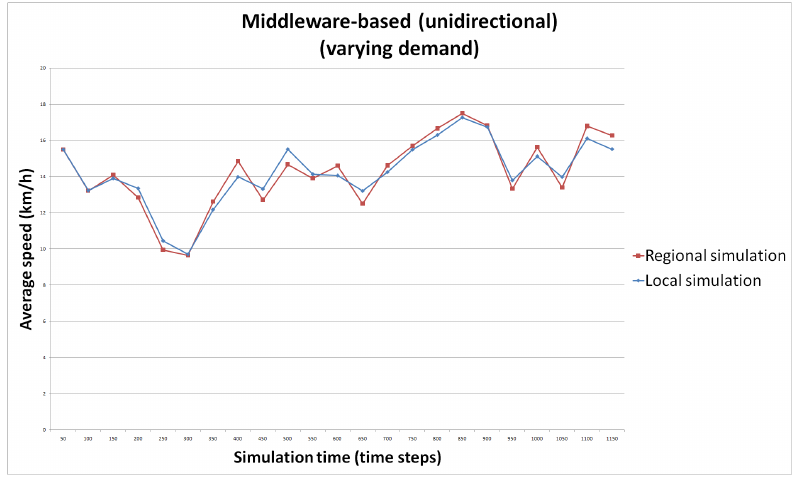
Figure 10. Average speeds for Scenario S4.